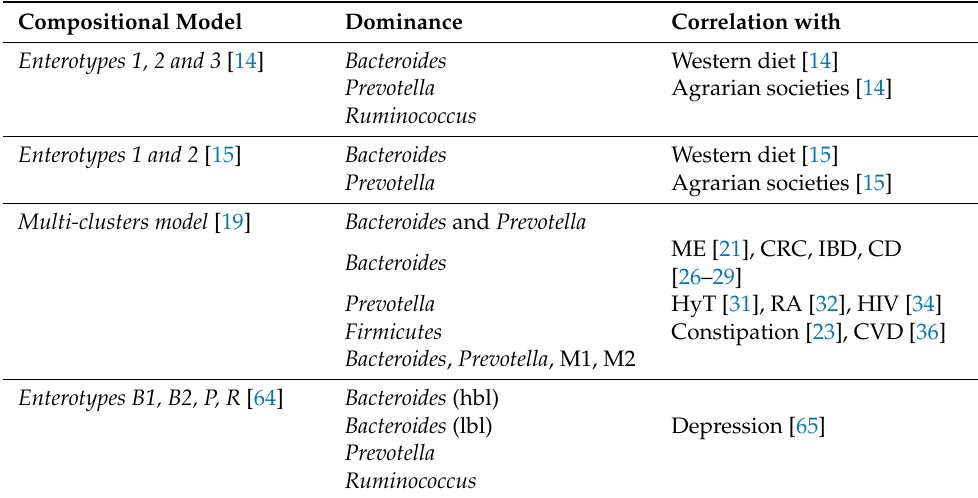
Table 1. Compositional models, bacterial dominance, diet, and possible disease